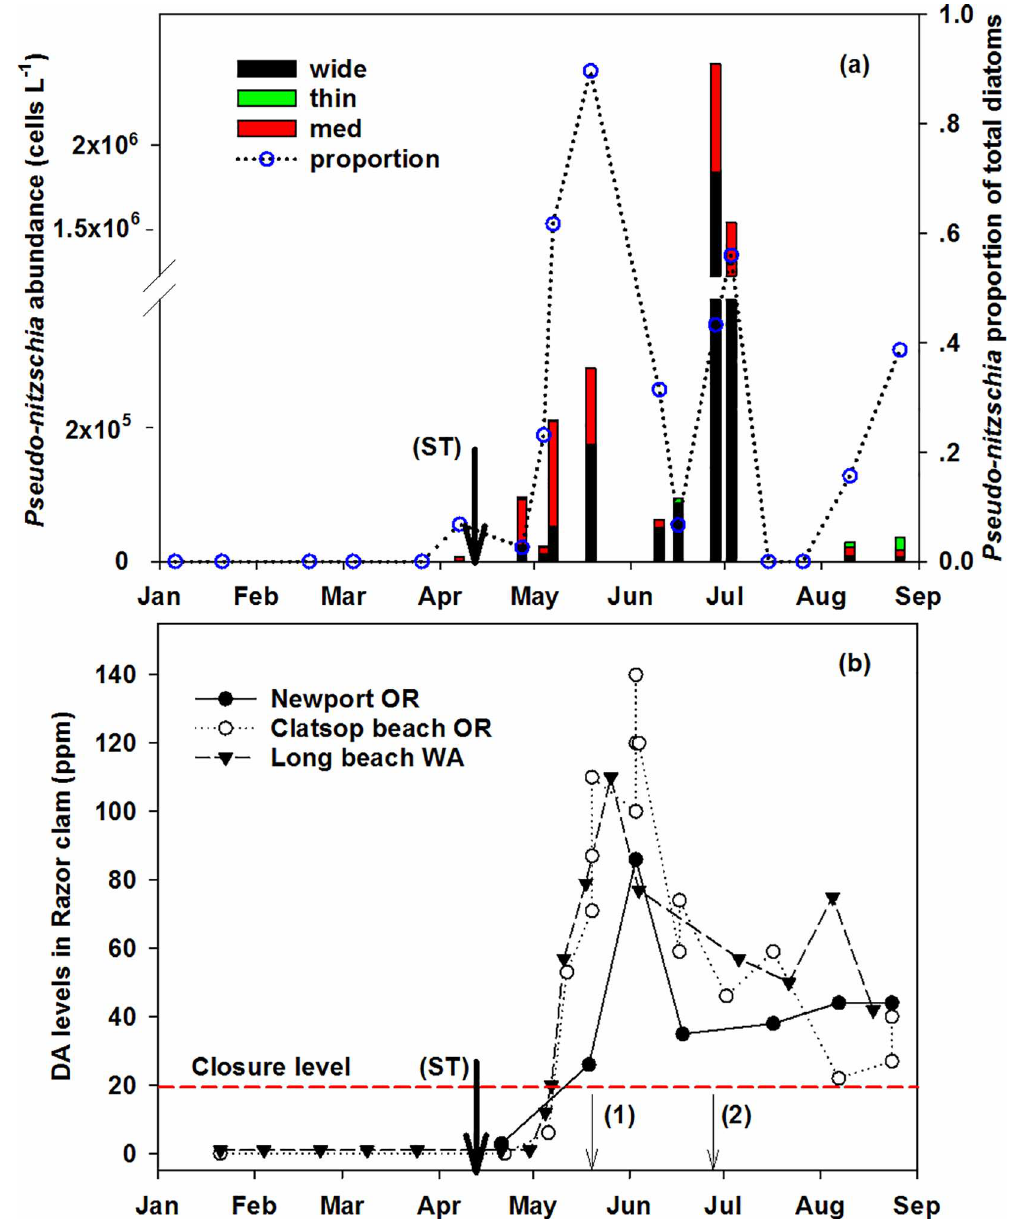
Fig 3. In situ observations of PN bloom and domoic acid in 2015. (a) The bloom initiationand development observed at the nearshore station NH5. Bars stacked by the three sized PN groups indicate cell abundances(left y-axis). Circles connected by dotted lines represent proportions of PN (blue circles, right y-axis) in the total diatom abundance.(b) Domoic acid (DA) concentrations (ppm) in razor clams. The dashed red line indicatesthe 20ppm closure threshold for razor clam harvest. Downward arrows mark the date of spring transition (ST) and timing of the first (1) and second (2) peaks of PN bloom in May and June,